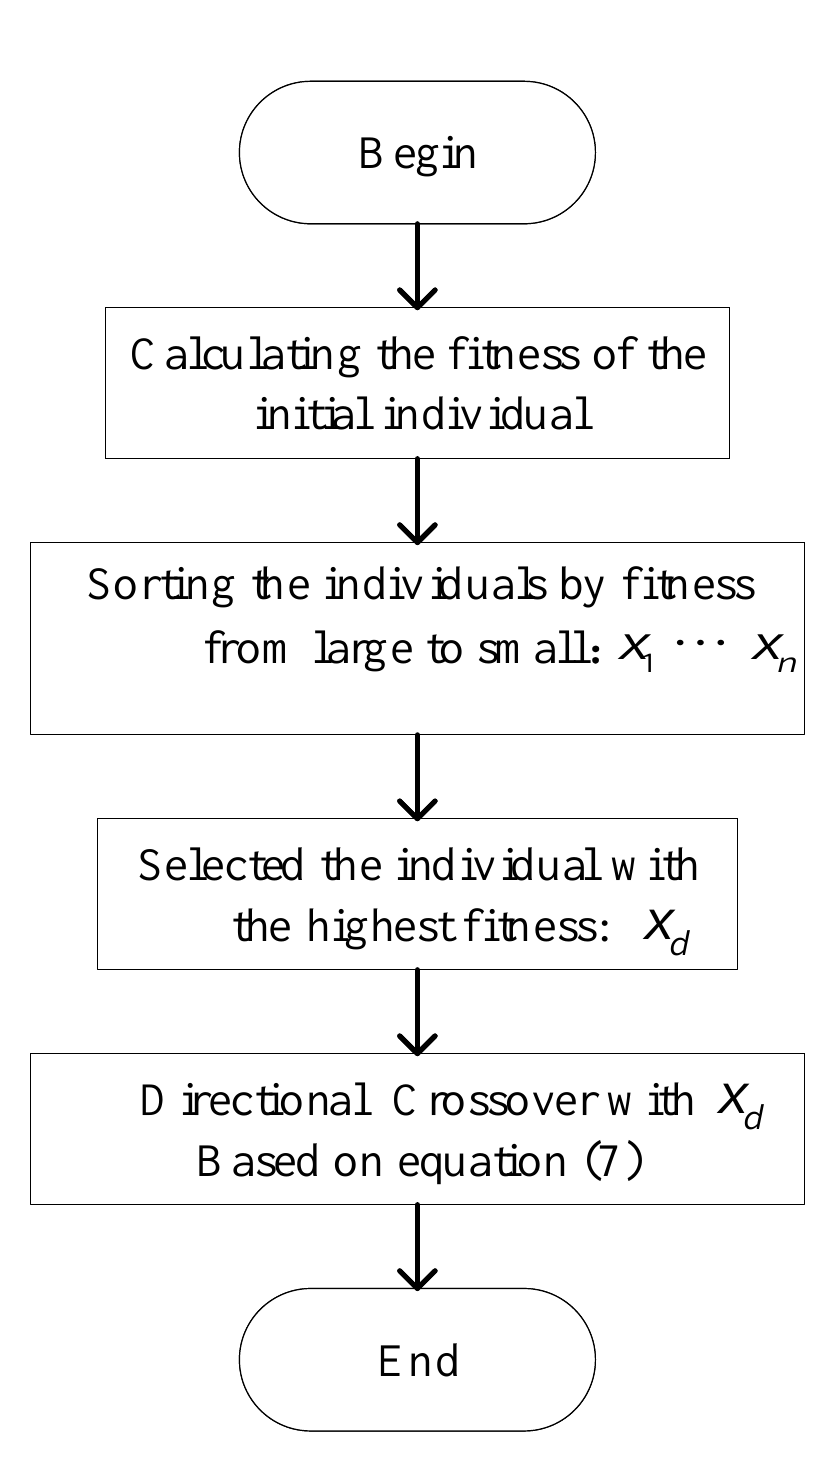
Figure 7. Schematic diagram of directional crossover